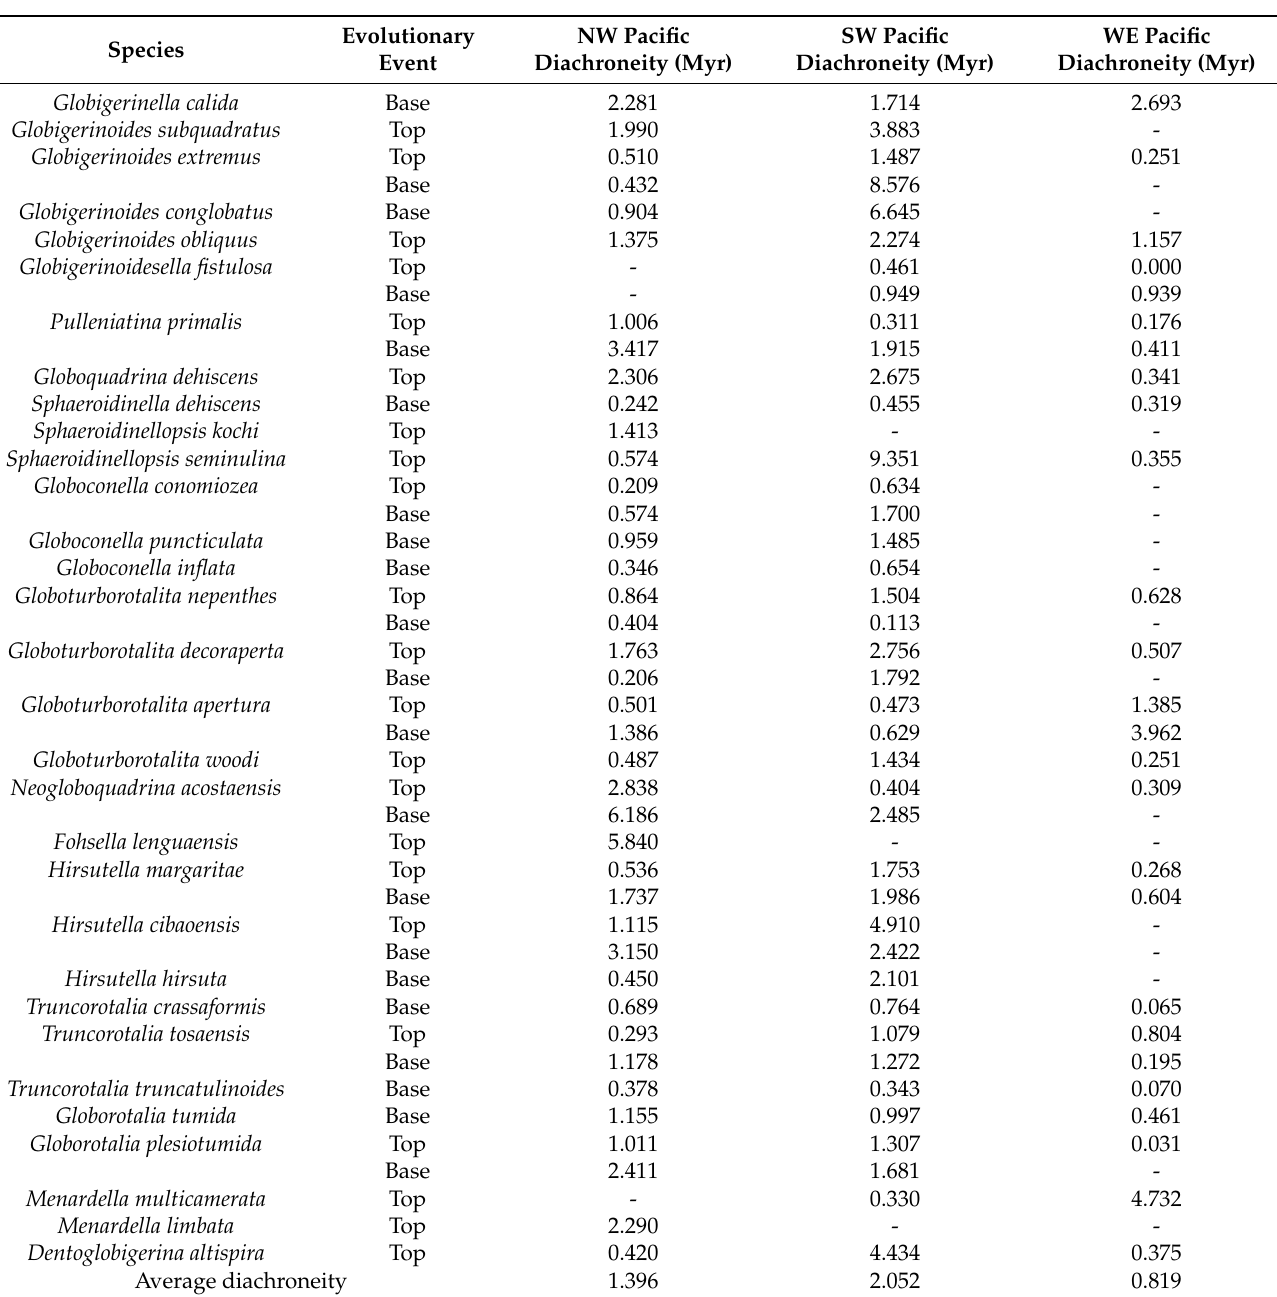
Table 3. Degree of diachroneity of planktic foraminiferal evolutionary events (latest occurrence of datum subtracted from earliest occurrence) across the northwest Pacific (Holes 1207A, 1208A, and 1209A), the southwest Pacific (Sites 587, 588, 589, 590, 591, 592, and 593), the western equatorial Pacific (Holes 806B and 586B), and the entire western Pacific (all western Pacific sites, excluding the datum dates from [13]). NW = northwest; SW = southwest; WE = western